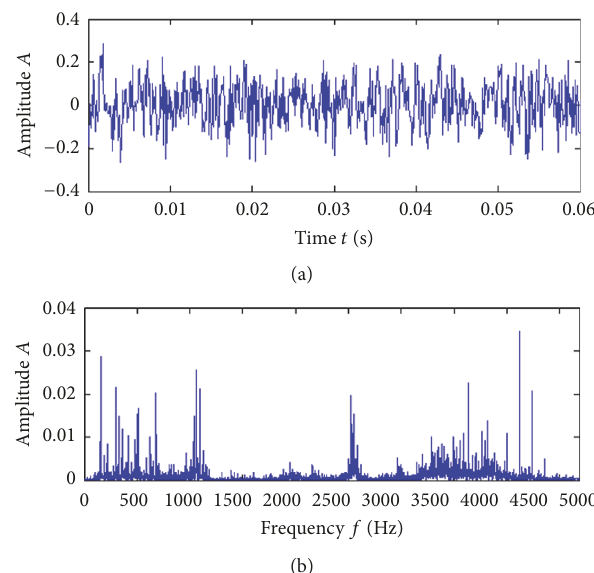
Figure 12: Vibration signal of slight rolling element fault: (a) time waveform and (b) the FFT spectrum.